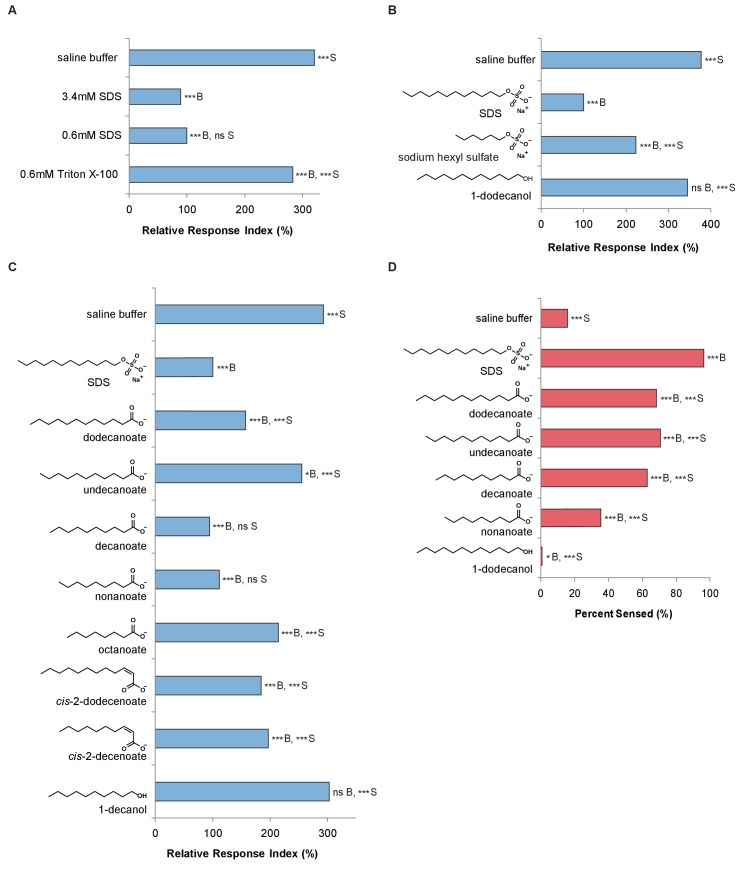
C. elegans avoids the SDS analogs dodecanoate and decanoate.(A) Quantification of the similar phasmid responses to 3.4 mM and 0.6 mM SDS, which is ten-fold below the critical micelle concentration of SDS. All other assays in this study were performed with 0.6 mM SDS to preclude the possibility of surfactant activity. The surfactant Triton X-100 at its critical micelle concentration is not strongly sensed by the phasmid neurons. (B) Quantification of the reduced responses to molecules with shorter tail length or a less polar head group than SDS. SDS and sodium hexyl sulfate were tested at 0.6 mM and 1-dodecanol was tested at 1 mM. (C) Quantification of the similar phasmid responses to SDS, dodecanoate, decanoate and nonanoate. All compounds except SDS were tested at 1 mM. Note that compounds are represented as the predominant form in a pH 7 solution, the carboxylates. (D) Quantification of the similar amphid responses to SDS, dodecanoate, decanoate and undecanoate, and slower responses to nonanoate and 1-decanol. All compounds except SDS were tested at 1 mM. Note that carboxylate forms are again represented. (A–C) For phasmid assays, one-way ANOVA and Tukey’s post-hoc test were performed. (D) For amphid assays, two-sample z-tests and the Hochberg multiple comparison adjustment procedure were performed. (A–D) For all experimental samples, n ≥ 40 for the experimental group, n ≥ 40 for the 0.6% SDS positive control, and n ≥ 40 for the saline buffer negative control. ***B, p<0.001; *B, p<0.05; ns B, not significant compared with a control buffer; ***S, p<0.001; ns S, not significant compared with SDS positive control. Exact values and additional pairwise comparisons are included in Figure 2—source data 1 and Figure 2—source data 2.10.7554/eLife.23770.009Figure 2—source data 1.Source data for Figure 2 and Figure 2—figure supplement 2.
10.7554/eLife.23770.010Figure 2—source data 2.Significance for pairwise comparisons for Figure 2 and Figure 2—figure supplement 2.